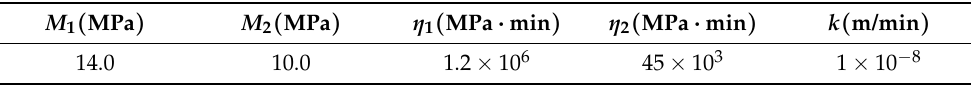
Table 1. Parameters assumed for the Burgers model in transient analysis for comparison with test